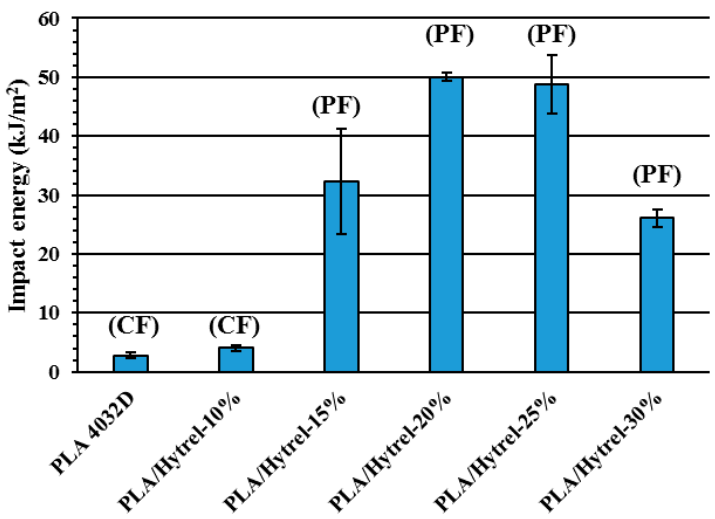
Figure 7. Impact energy of neat PLA and compounded PLA with various Hytrel contents (CF: complete fracture, PF: partial fracture).